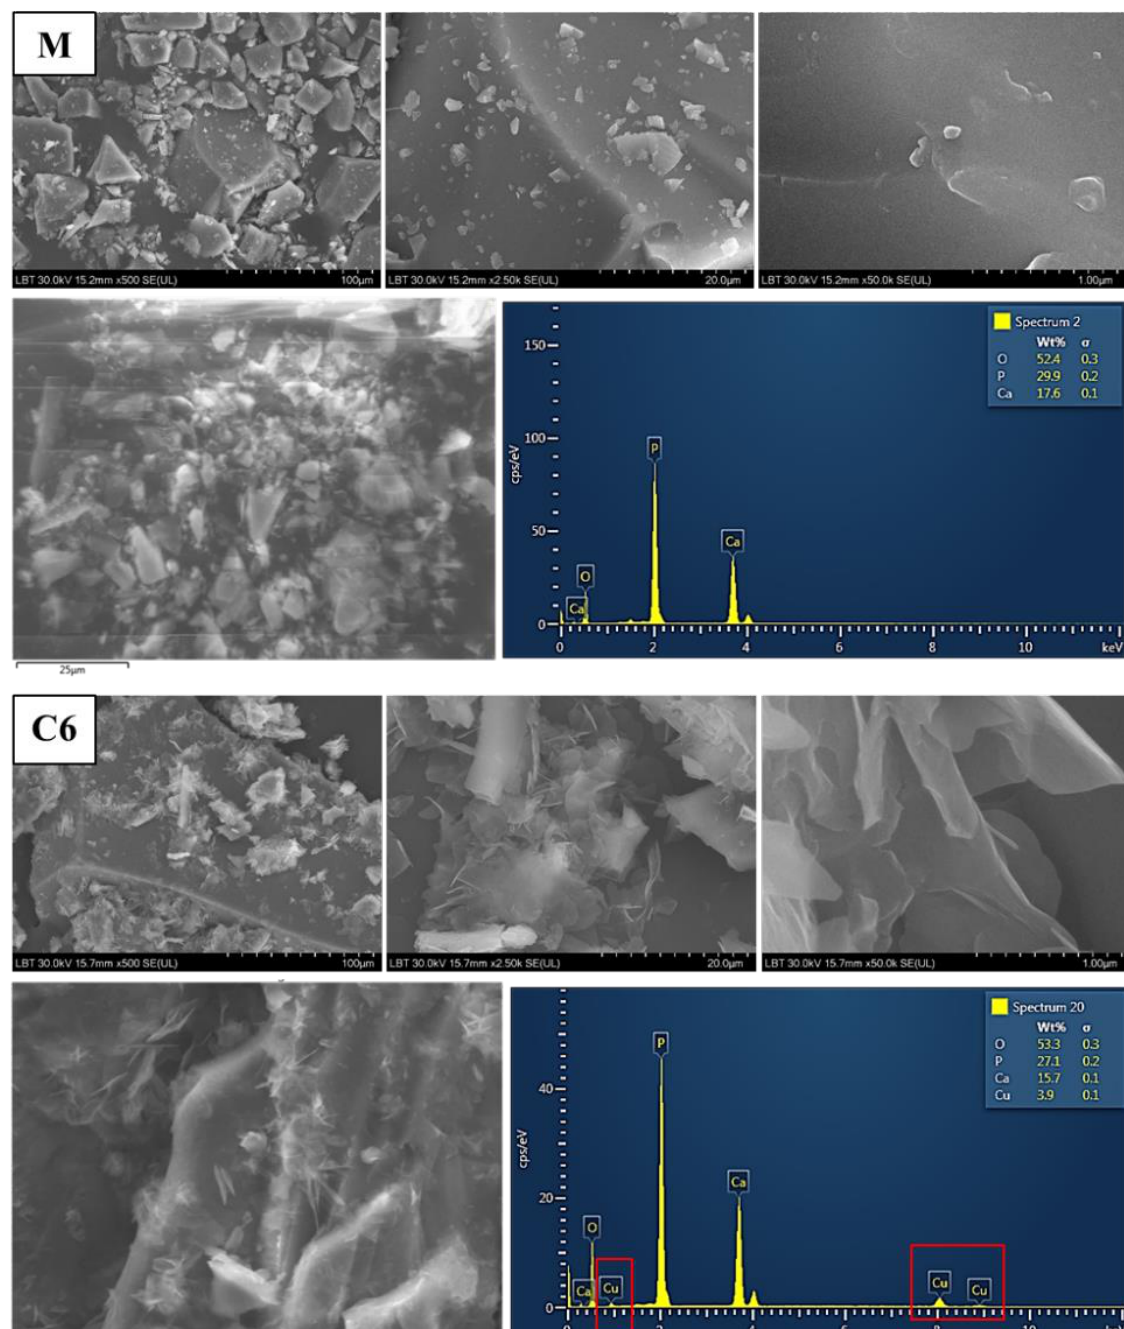
Figure 4. SEM images and EDX spectra for x = 0 and 1 mol% CuO glasses before the dissolution experiments. Table 3. The average overall chemical composition of xCuO∙(100 − x) [CaF 2 ∙3P 2 O 5 ∙CaO] glass system by EDX analysis.